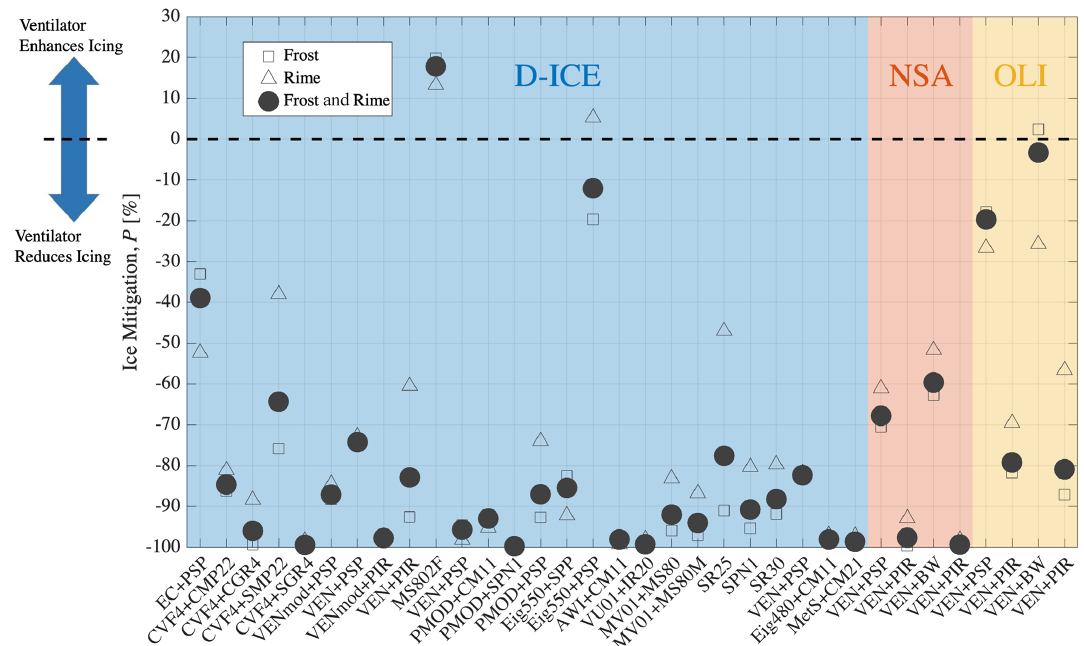
Figure 8. Ice mitigation performance metric, P (Eq. 1 from main text), for tested systems at D-ICE (blue background) and DICEXACO (Utqia˙gvik “NSA” in red, Oliktok Point “OLI” in yellow). Solid circles refer to a combination of rime and frost while open squares are frost only and open triangles are rime